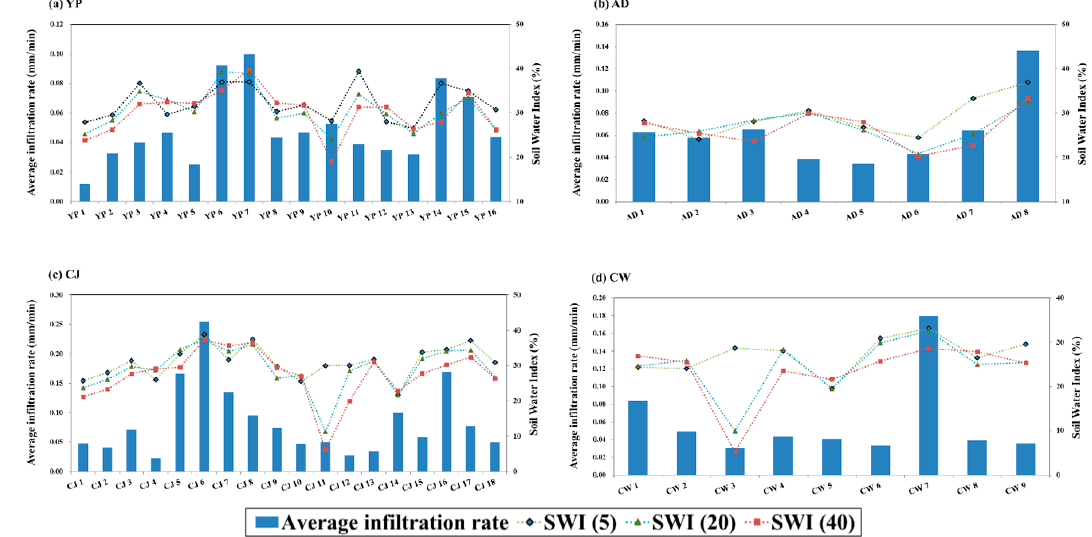
Figure 7. Average infiltration rate in the rainfall events and the relationship between soil wetness conditions ( T = 5, 20, and 40) and the average infiltration rate at four sites: ( a ) YP; ( b ) AD; ( c ) CJ; and ( d ) CW.